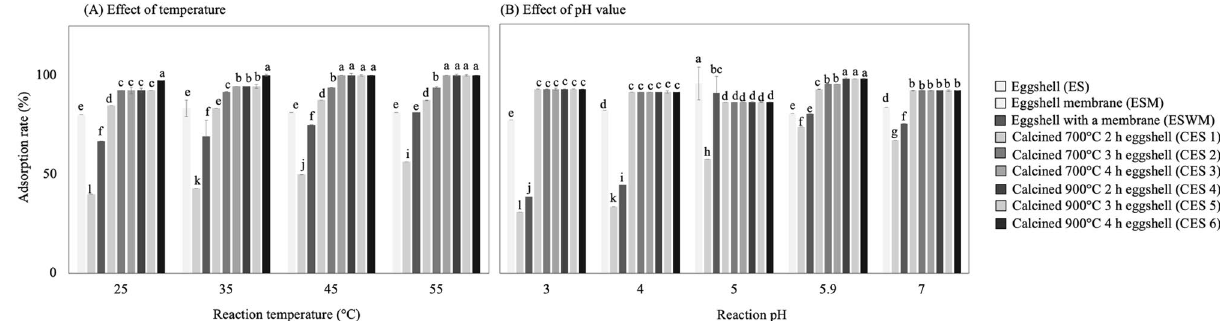
Figure 2. The adsorption rates of differently treated eggshells were influenced by single factors ( A ) reaction temperature and ( B ) pH of the reaction,